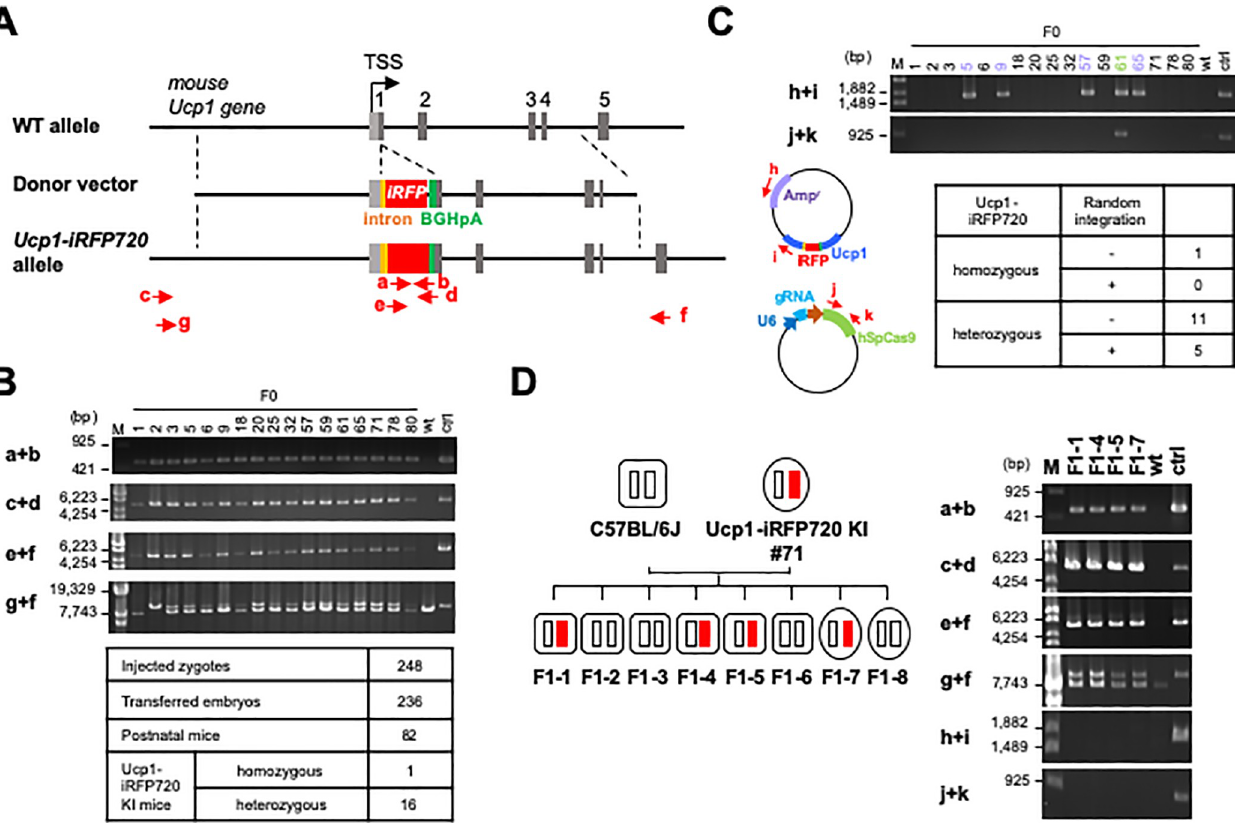
Fig 2. Generation of Ucp1-iRFP720 KI mice. (A) Targeting of the iRFP720 gene into the Ucp1 locus. The donor vector contains an artificial intron (orange box), iRFP720 gene (red box) and the bovine growth factor gene-derived polyadenylation signal (BGHpA) (green box). Structure of the targeted allele is indicated together with the primers used for genomic PCR (red arrows). (B) Genomic PCR analysis of F0 mice carrying the Ucp1-iRFP720 KI allele. M, marker; wt, wild-type; ctrl, positive control (a DNA fragment that covers the amplicon sequence between the primers c and f in Fig 2A). (C) PCR analysis of the donor vector and the gRNA/Cas9-expression vector randomly integrated into the F0 mouse genome. The table shows the summary of random integration in the F0 mouse genome carrying the Ucp1-iRFP720 allele. (D) Mendelian inheritance of the Ucp1-iRFP720 KI allele. One of the Ucp1-iRFP720 KI mice (#71) was crossed with a WT mouse, and eight F1 mice were born. Their genotypes were analyzed by PCR using the primer sets shown in Fig 2A. Small white and red rectangles show WT Ucp1 and Ucp1-iRFP720 KI alleles, respectively. Rounded rectangles and ellipses indicate male and female mice, respectively.